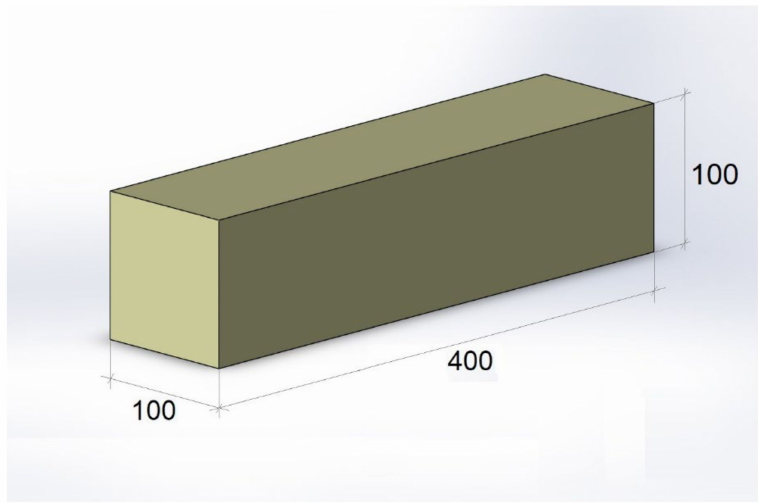
Figure 4. Sample with homogeneous fibers distribution in the volume (Group A1). Group A2